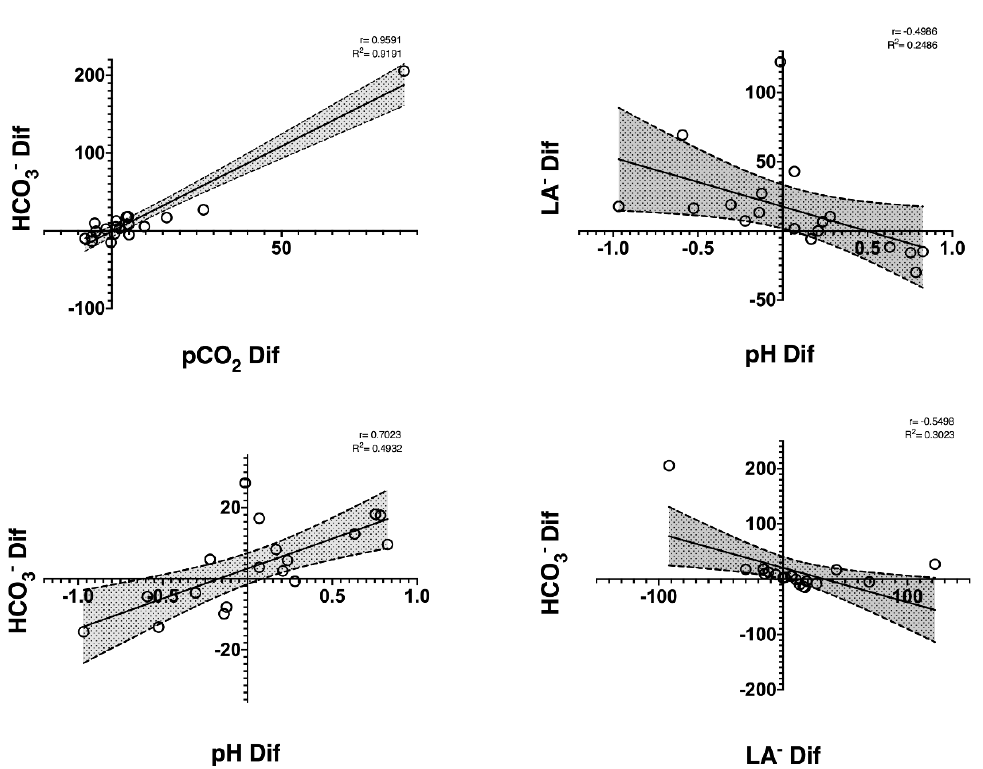
Figure 3. Correlations found between capillary blood gases variables after an incremental test at the end of the off-season period in well-trained cyclists. All correlations were significant at <0.05.